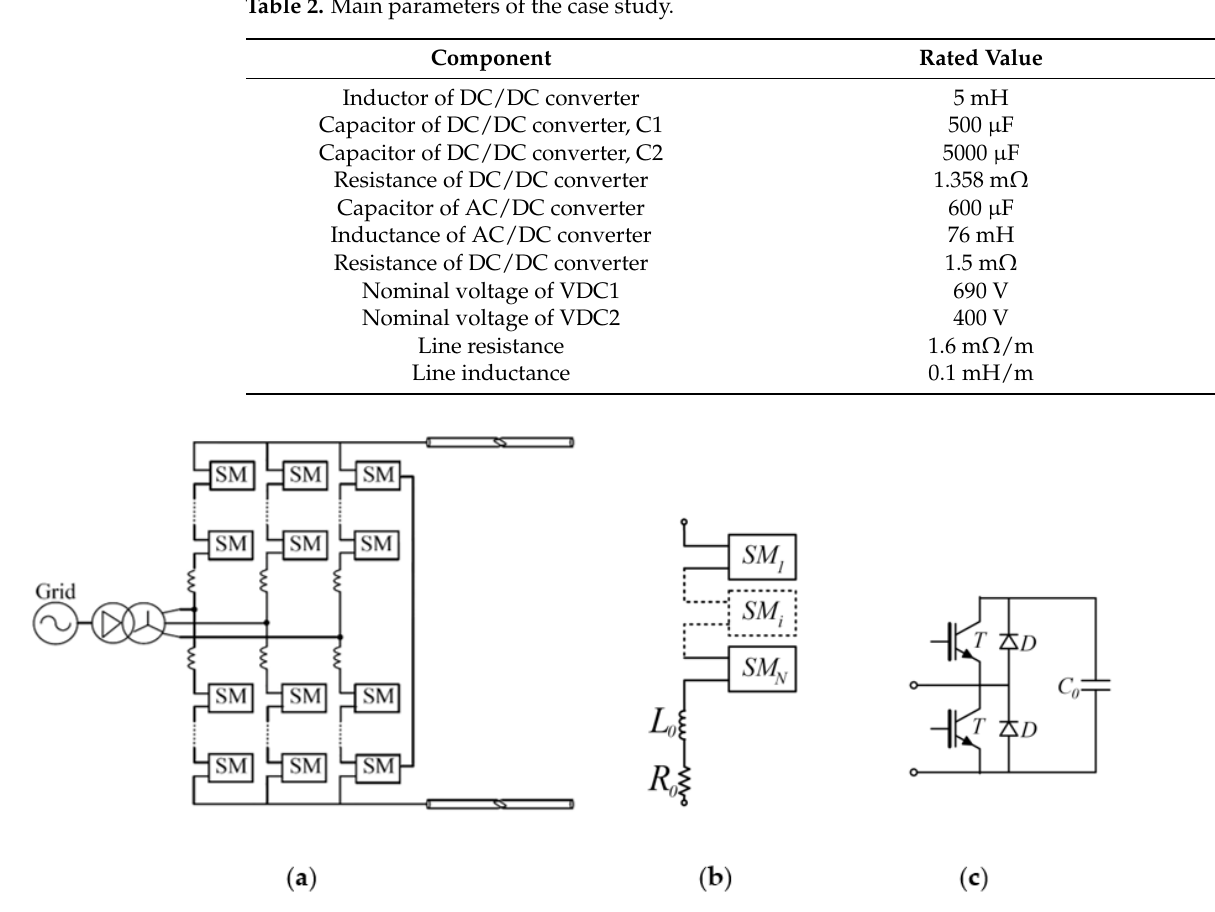
Figure 2. ( a ) Structure of an AC/DC MMC, ( b ) structure of each arm, ( c ) equivalent model of SM.